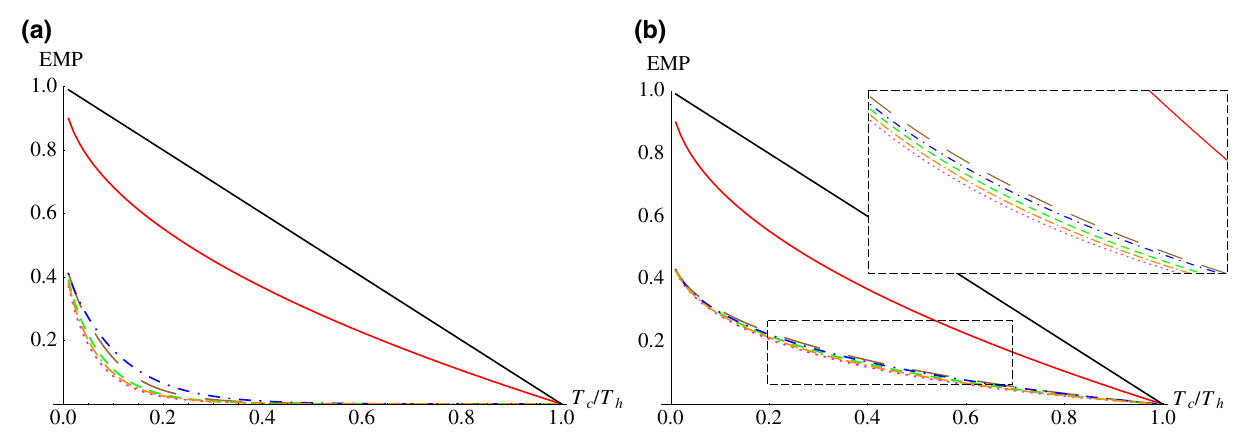
FIG. 13. Nonequilibrium EMP as a function of the ratio of bath temperatures for two statistical anyons in one dimension with p B = 1 (long dashed, brown), p B = 1 / 2 (short dashed, green), p B = 0.25 (dot dash dashed, orange), p B = 0 (dotted, dark pink), and two distinguishable quantum particles (dot dashed, blue). The Curzon-Ahlborn efficiency (lower solid, red) and Carnot efficiency (top solid, black) are given in comparison. Plot (a) shows operation in the regime corresponding to (cid:2) ω 2 / k B T c = 10 and (b) in the regime corresponding to (cid:2) ω 2 / k B T c = 1. We set τ =